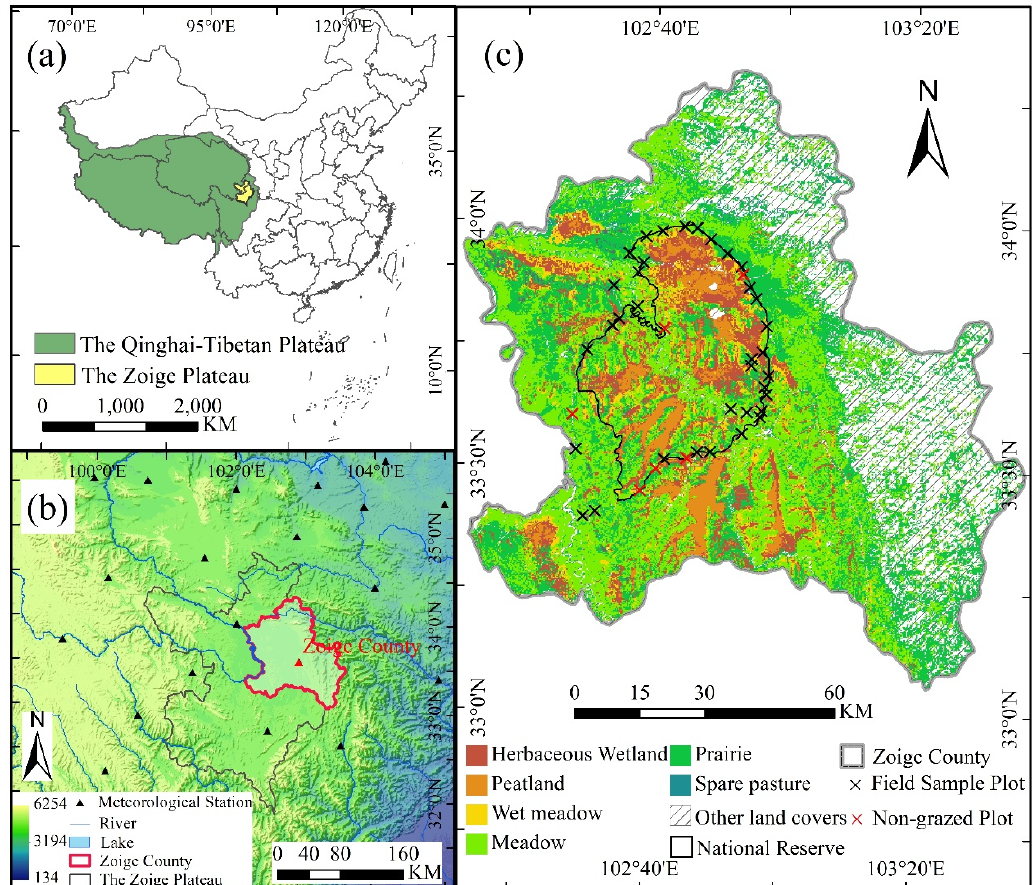
Figure 1. ( a ) Location of the Zoige Plateau in China; ( b ) the digital elevation model (DEM) of the study area and the spatial distribution of meteorological stations around the Zoige County; and ( c ) land cover types in study area and the spatial distribution of field sample plots used for model validation.